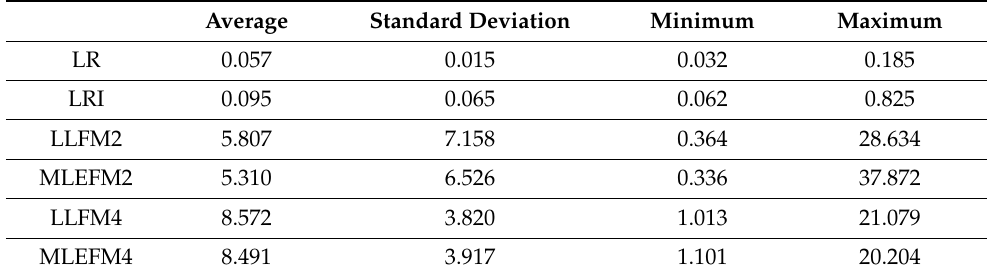
Table 7. Time that the estimation algorithms of the models took to converge over the simulation